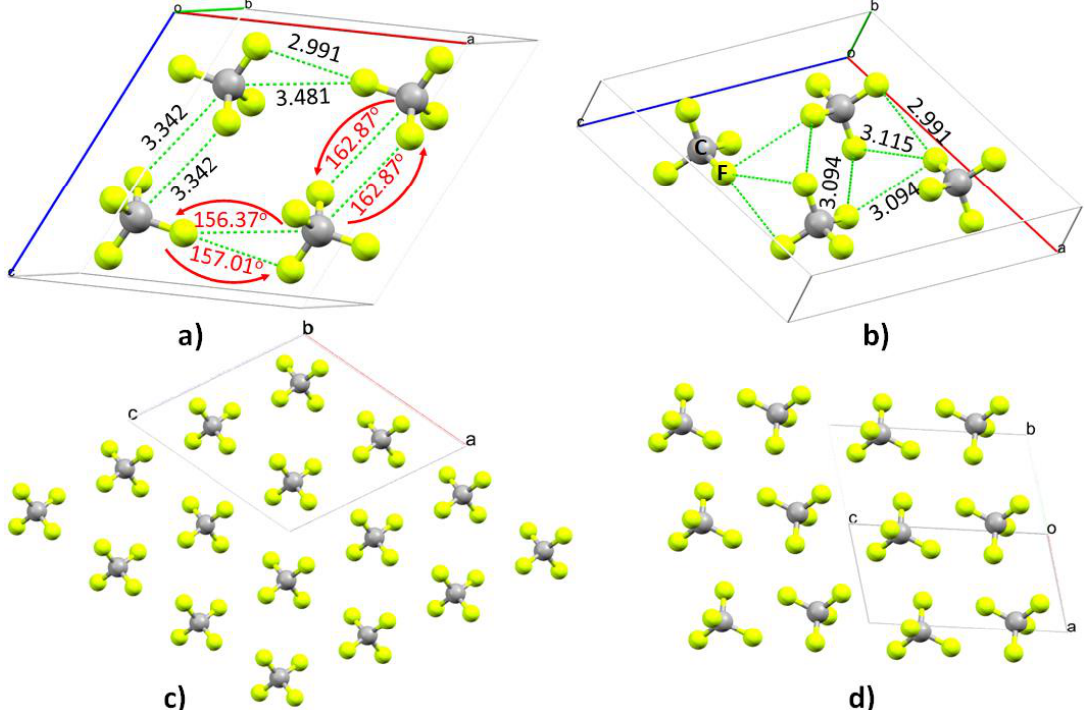
Figure 9. Various views of the ball-and-stick models of the unit cell of carbon tetrafluoride (CF 4 ) (CSD ref: TEMETH02): ( a , b ) unit cell and ( c , d ) 2 × 2 supercell. The F · · · F and F · · · C intermolecular bond distances and angles in ( a , b ) are in Å and degrees, respectively.